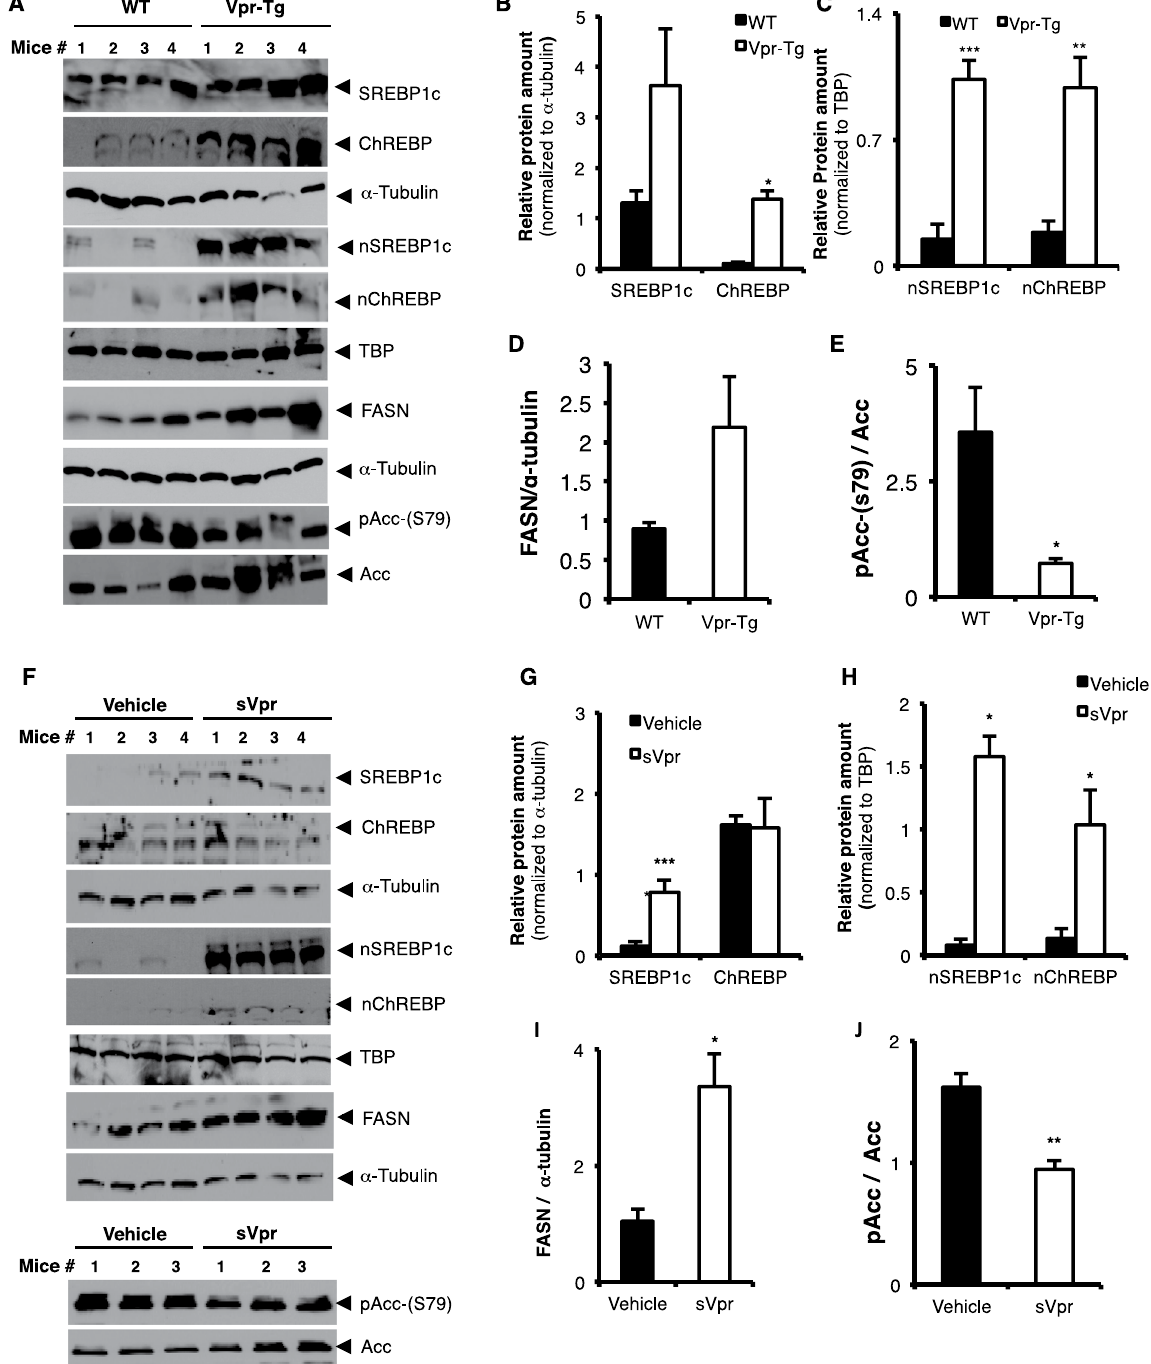
Figure 3. Increased amounts and activation of regulatory lipogenic proteins in liver of Vpr-Tg and sVpr- treated mice. ( A ) Immunoblots show expression of transcription factors and their target proteins in Vpr-Tg vs. WT mice (N = 4 per group). ( B ) There was a trend towards increased SREBP1c (P = 0.1) and increased ChREBP expression in whole cell extracts of Vpr-Tg compared to WT mice (N = 4 per group). ( C ) SREBP1c and ChREBP amounts were increased in nuclear fractions of Vpr-Tg compared to WT mice (N = 4 per group). ( D ) There was a trend towards increased FASN (p = 0.1) in Vpr-Tg compared to WT mice (N = 4 per group). ( E ) The ratio of phosphoS79-Acc to ACC was decreased in whole cell extracts of Vpr-Tg compared to WT mice (N = 4 per group). ( F ) Immunoblots show expression of transcription factor and their target proteins in sVpr- treated vs. vehicle-treated mice (N = 4 per group; N = 3 per group for ACC/pACC). ( G ) There was increased SREBP1c but not ChREBP in whole cell extracts of sVpr-treated compared to vehicle-treated mice (N = 4 per group). ( H ) There was increased SREBP1c and ChREBP in nuclear fractions of sVpr-treated compared to vehicle-treated mice (N = 4 per group). ( I,J ) There were increased FASN (N = 4 per group) and decreased ratio of phosphoS79-ACC to ACC (N = 3 per group) in whole cell extracts of sVpr-treated compared to